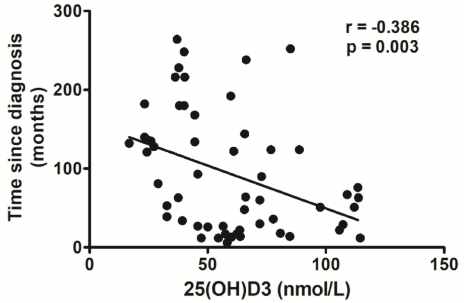
Figure 1. Correlation analysis between 25(OH)D 3 plasma levels and time since HIV diagnosis.